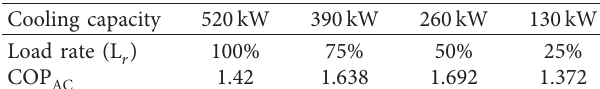
Table 6: Absorption chiller parameter.